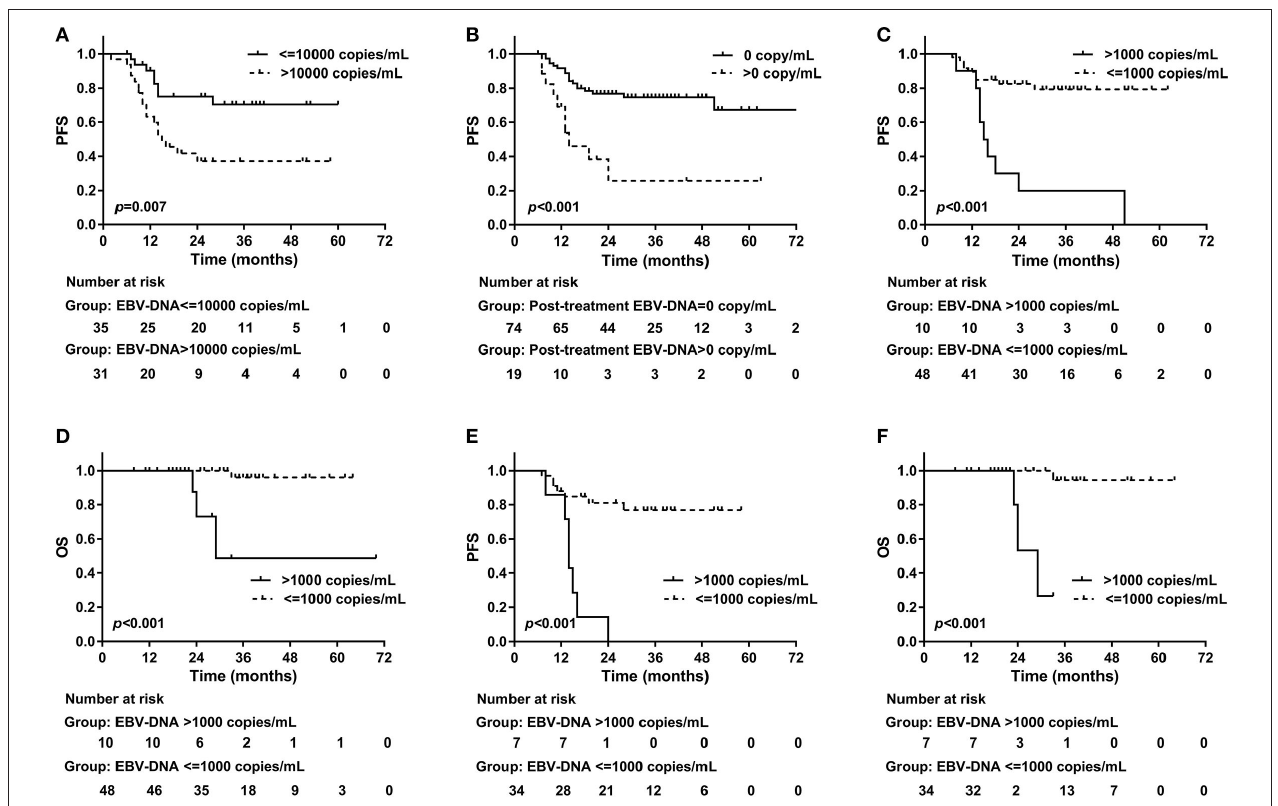
FIGURE 2 | Progression-free survival and plasma EBV-DNA results. (A) Pre-treatment plasma EBV-DNA copy number > 10,000 indicated an impaired 2-year PFS ( > 10,000 vs. ≤ 10,000 copies/mL, 37.2 vs. 75.1%, p = 0.007, log-rank); (B) Positive post-treatment plasma EBV-DNA was associated with worse 2-year PFS ( > 0 vs. 0 copy/mL, 25.6 vs. 76.8%, p < 0.001, log-rank). During follow-up, an increasing EBV-DNA with the copy number exceeding 1,000 copies/mL predicted worse (C) 2-year PFS ( > 1,000 copies/mL vs. ≤ 1,000 copies/mL, 20.0 vs. 82.5%, p < 0.001, log-rank) and (D) 2-year OS ( > 1,000 copies/mL vs. ≤ 1,000 copies/mL, 72.9 vs. 100%, p < 0.001, log-rank). In patients with complete EBV-DNA results, an increasing EBV-DNA with the copy number exceeding 1,000 copies/mL predicted worse (E) 2-year PFS ( > 1,000 copies/mL vs. ≤ 1,000 copies/mL, 0 vs. 81.0%, p < 0.001, log-rank) and (F) 2-year OS ( > 1,000 copies/mL vs. ≤ 1,000 copies/mL, 53.3 vs. 100%, p < 0.001, log-rank). EBV, Epstein-Barr virus; DNA, deoxyribonucleic acid; PFS, Progression-free survival; OS, overall survival.